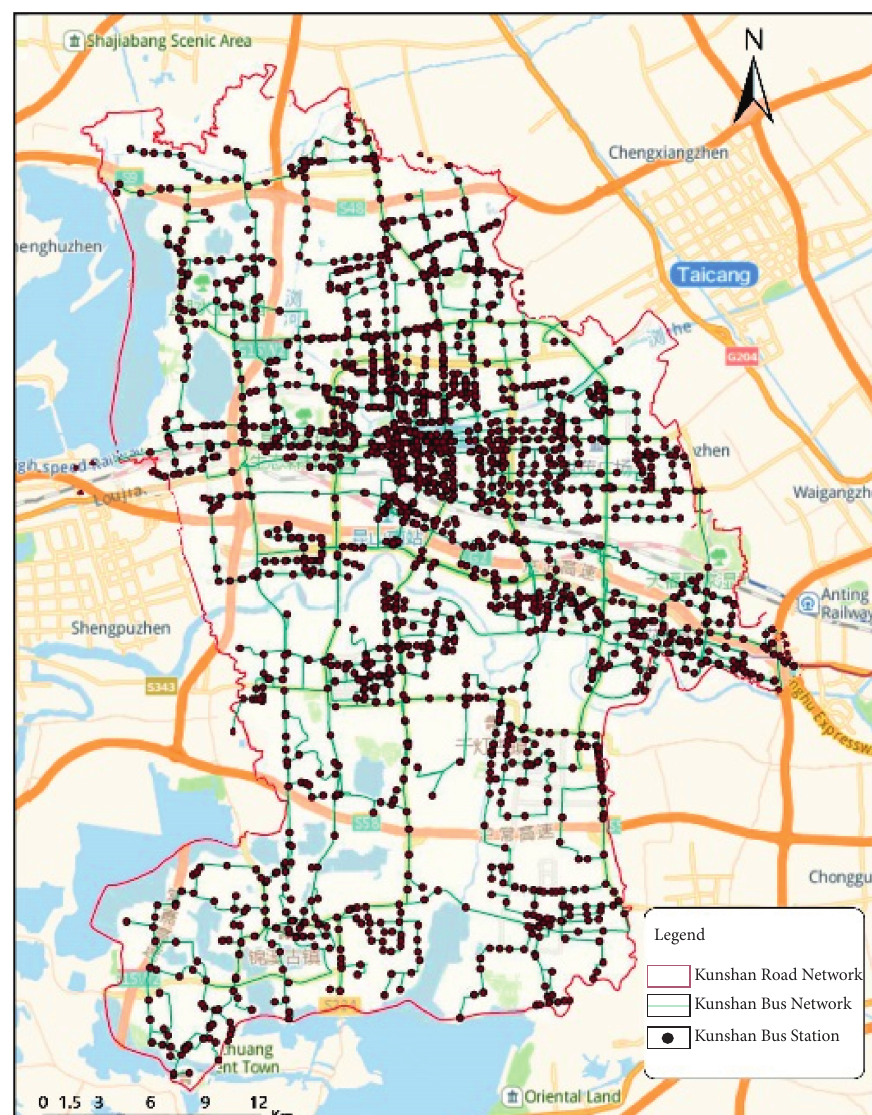
Figure 7: Layout of public transport Table 8: Public transport and car accessibility in Kunshan Theil index contribution (%).